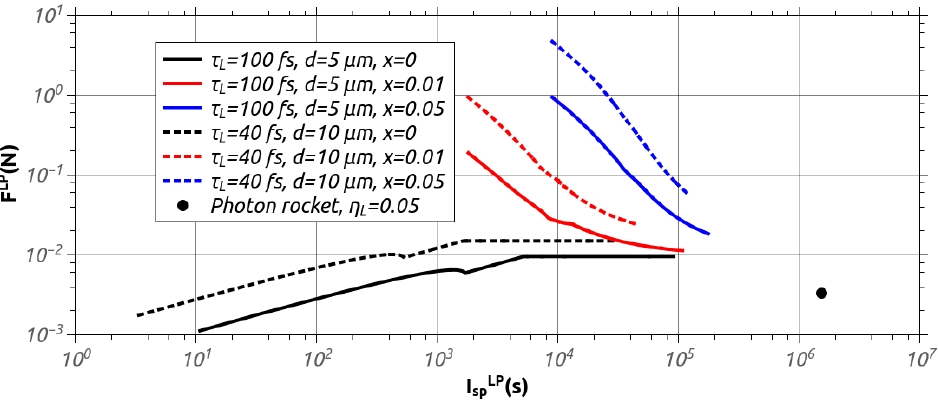
Figure 8. Thrust as a function of the specific impulse at fixed pulse energy ε L = 10 3 J. A uniformly ionized C 6 + target with a density of ρ = 1 g/cm 3 has been considered. The laser repetition rate is fixed by ν L = 1 kHz. In case of photon rocket, the thrust is given by F L = ν L ε L / c